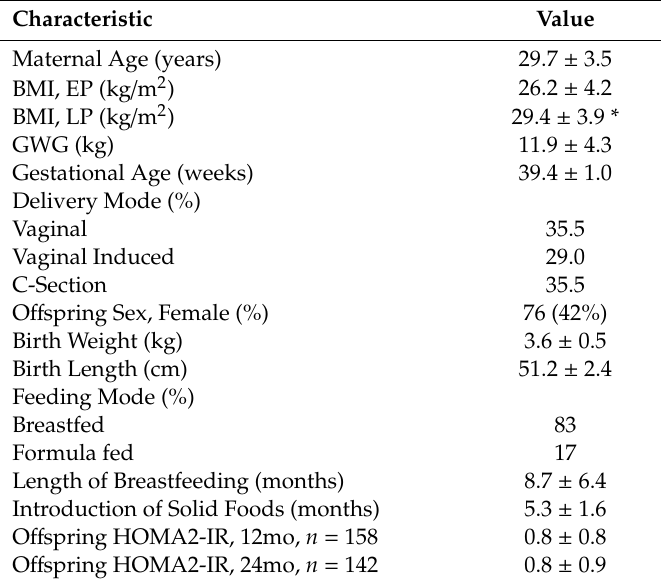
Table 1. Descriptive Characteristics, n = 182.